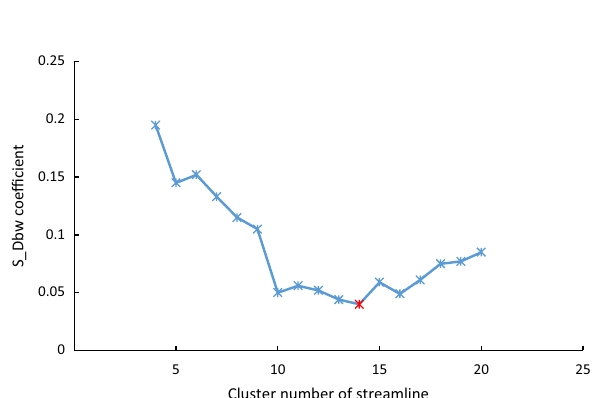
Fig. 6 Re between cluster number of streamline cluster and S_Dbw